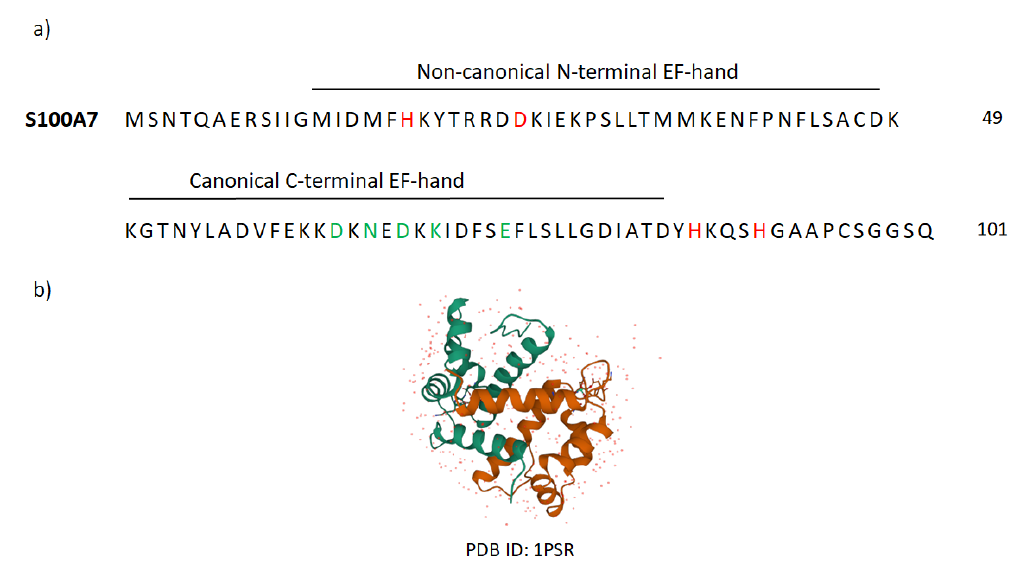
Figure A2. Structures of S100A7 protein: ( a ) predicted amino acid sequence of the human S100A7 (the red color marks those amino acids that bind Zn 2+ , while the green color marks the amino acids that bind Ca 2+ ); ( b ) structure of human S100A7—image from the RCSB PDB (rcsb.org) of PDB ID 1PSR [272].